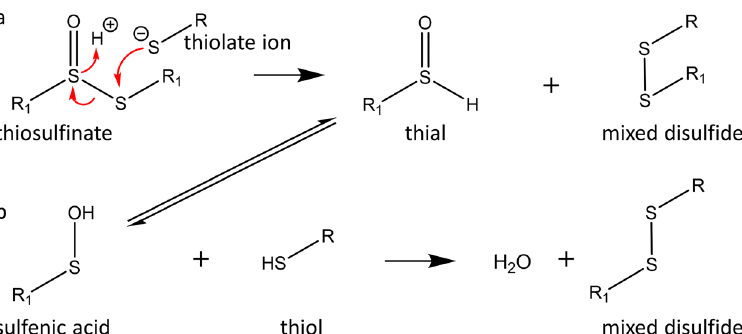
Figure 2. Reaction mechanism of a thiol with a thiosulfinate. The reaction leads directly ( a ), and indirectly ( b ), to the formation of a mixed disulfide, which under some conditions may react further with RSH in a thiol disulfide exchange reaction to form RSSR and R 1